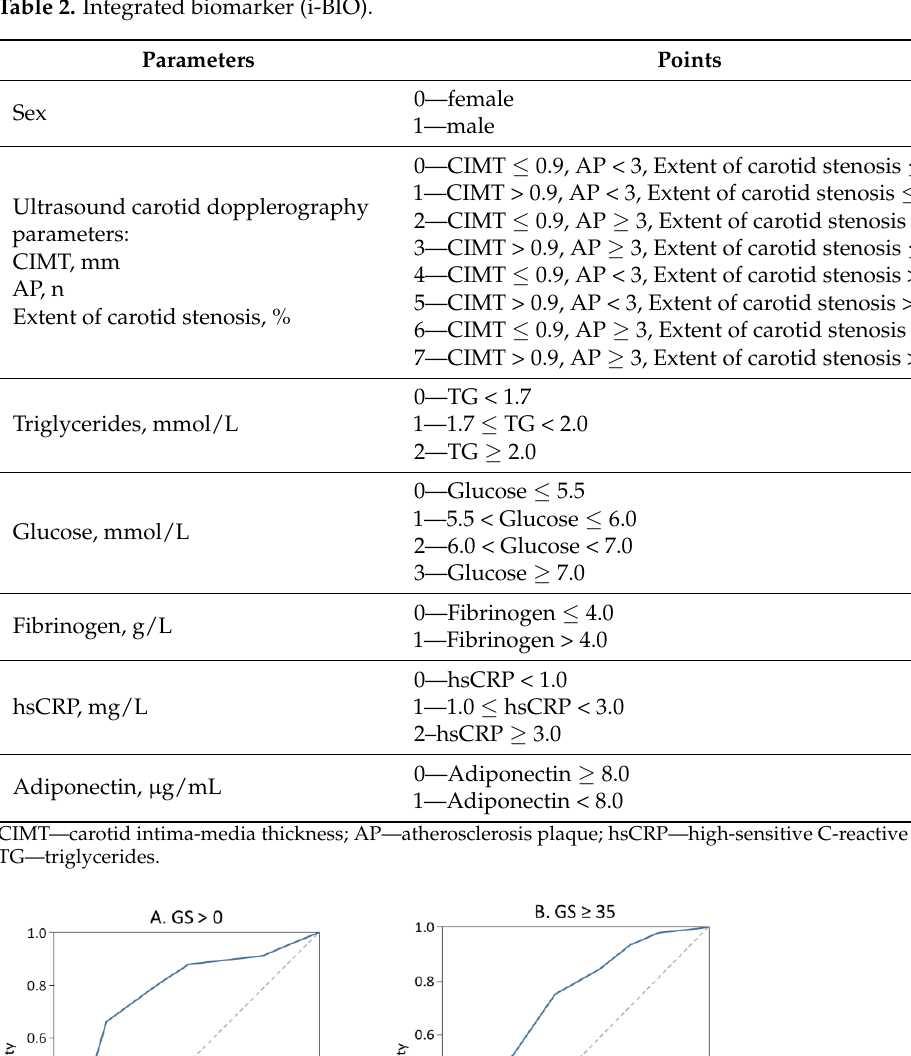
Table 2. Integrated biomarker (i-BIO).